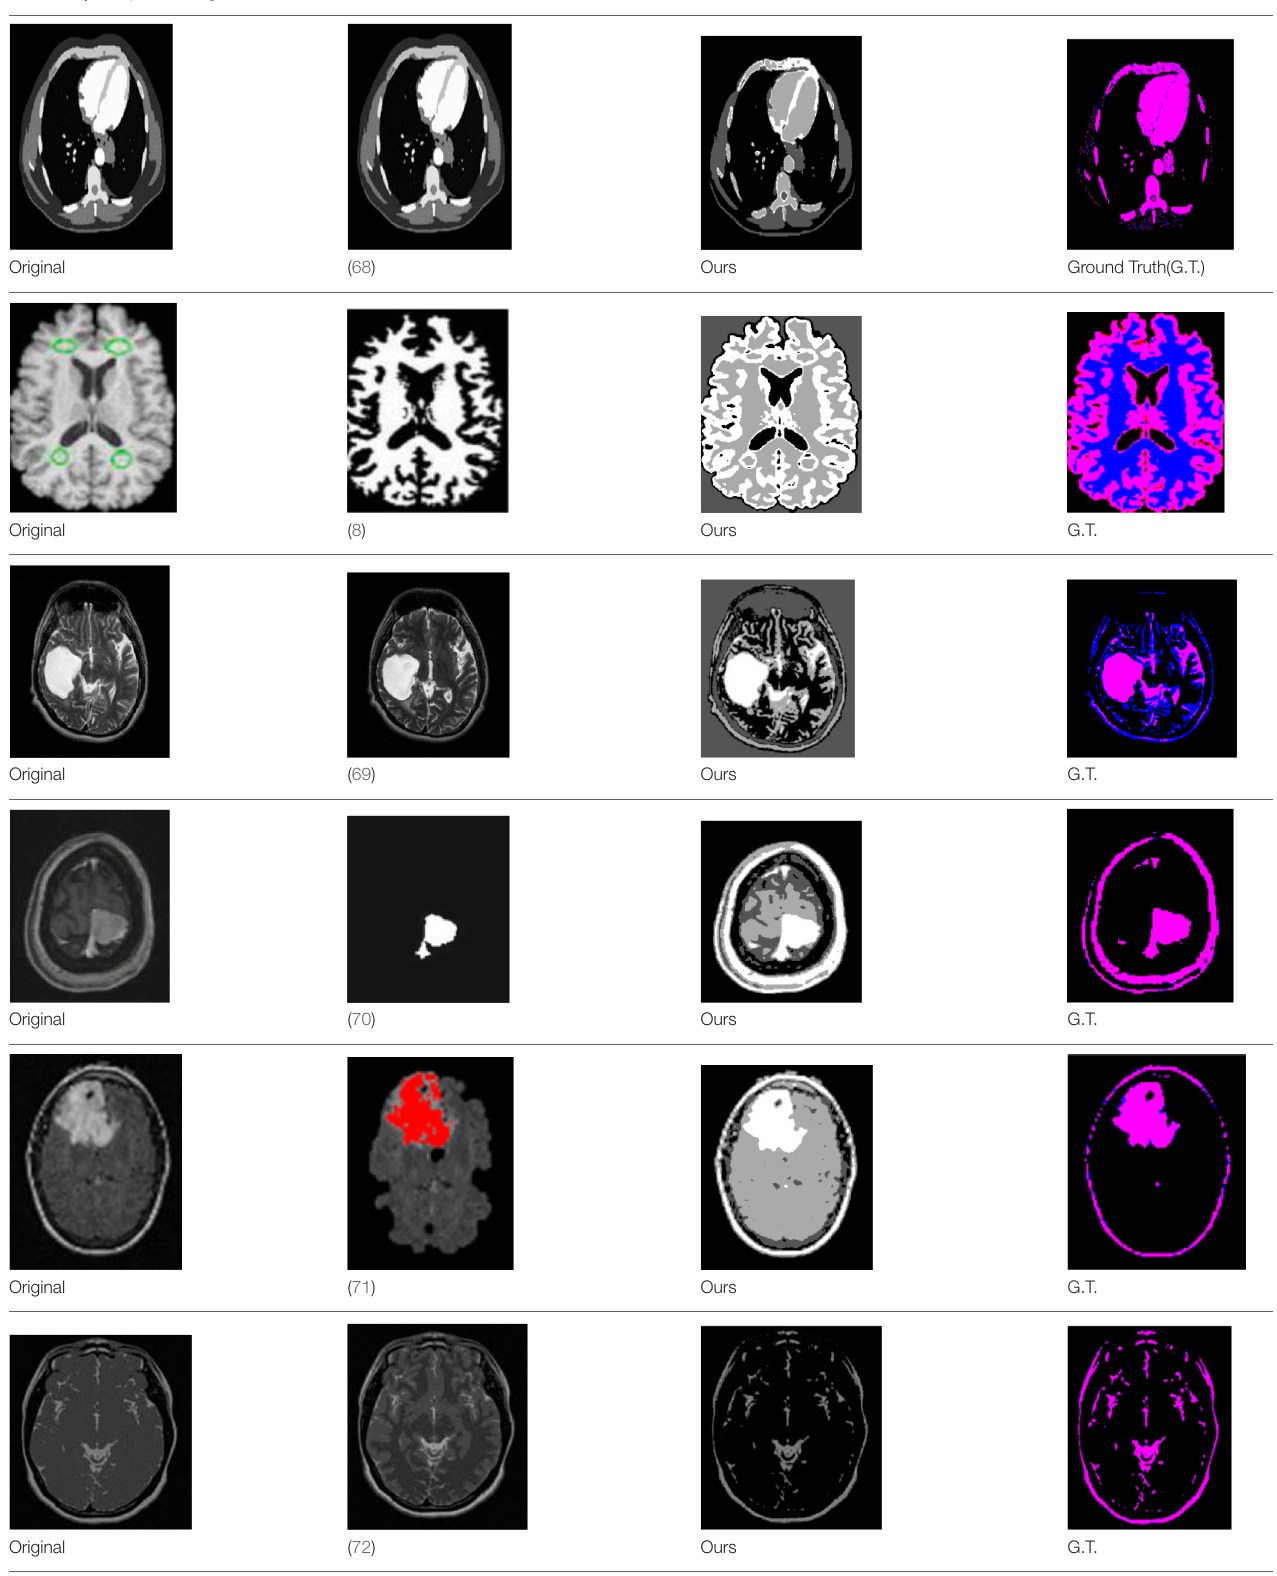
TABLE 5 | Comparison segmentation